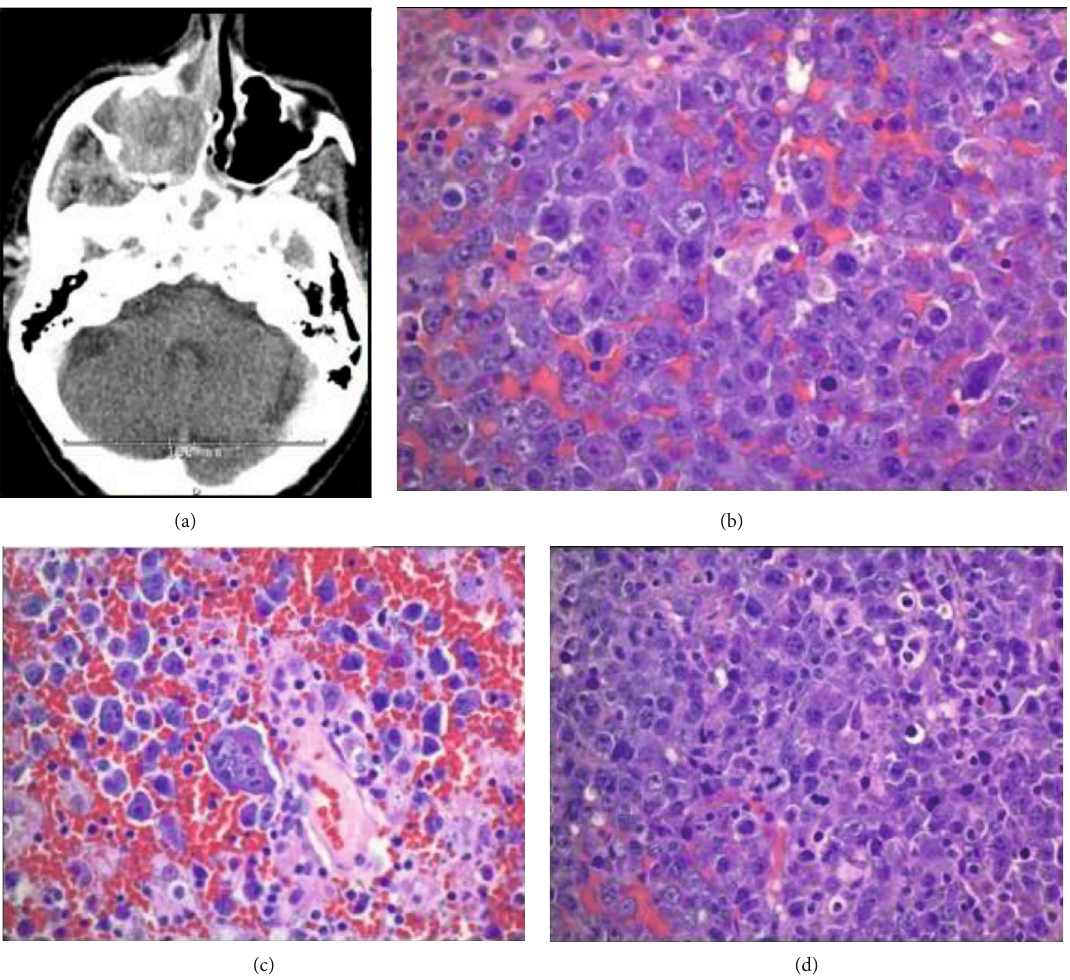
Figure 1: (a) CT right maxillary sinus mass. (b) Tumor cells forming sheets with a relatively cohesive growth pattern many exhibiting plasmablastic morphology (H&E, 400x). (c) Bizarre/anaplastic forms (H&E, 400x). (d) Abundant mitotic and apoptotic activity (H&E,